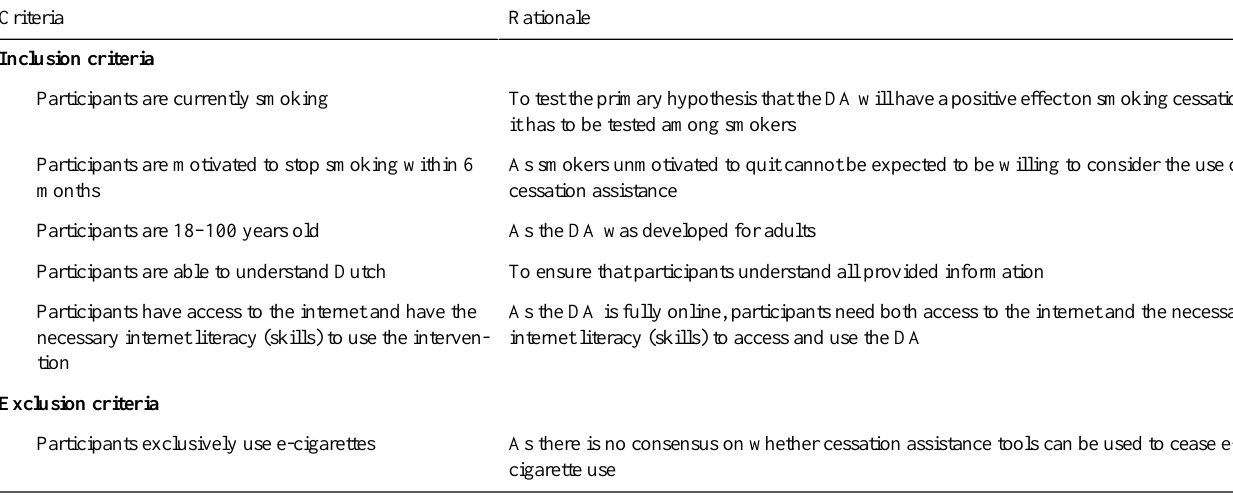
Table 1. Overview of the randomized controlled trial inclusion and exclusion criteria, including